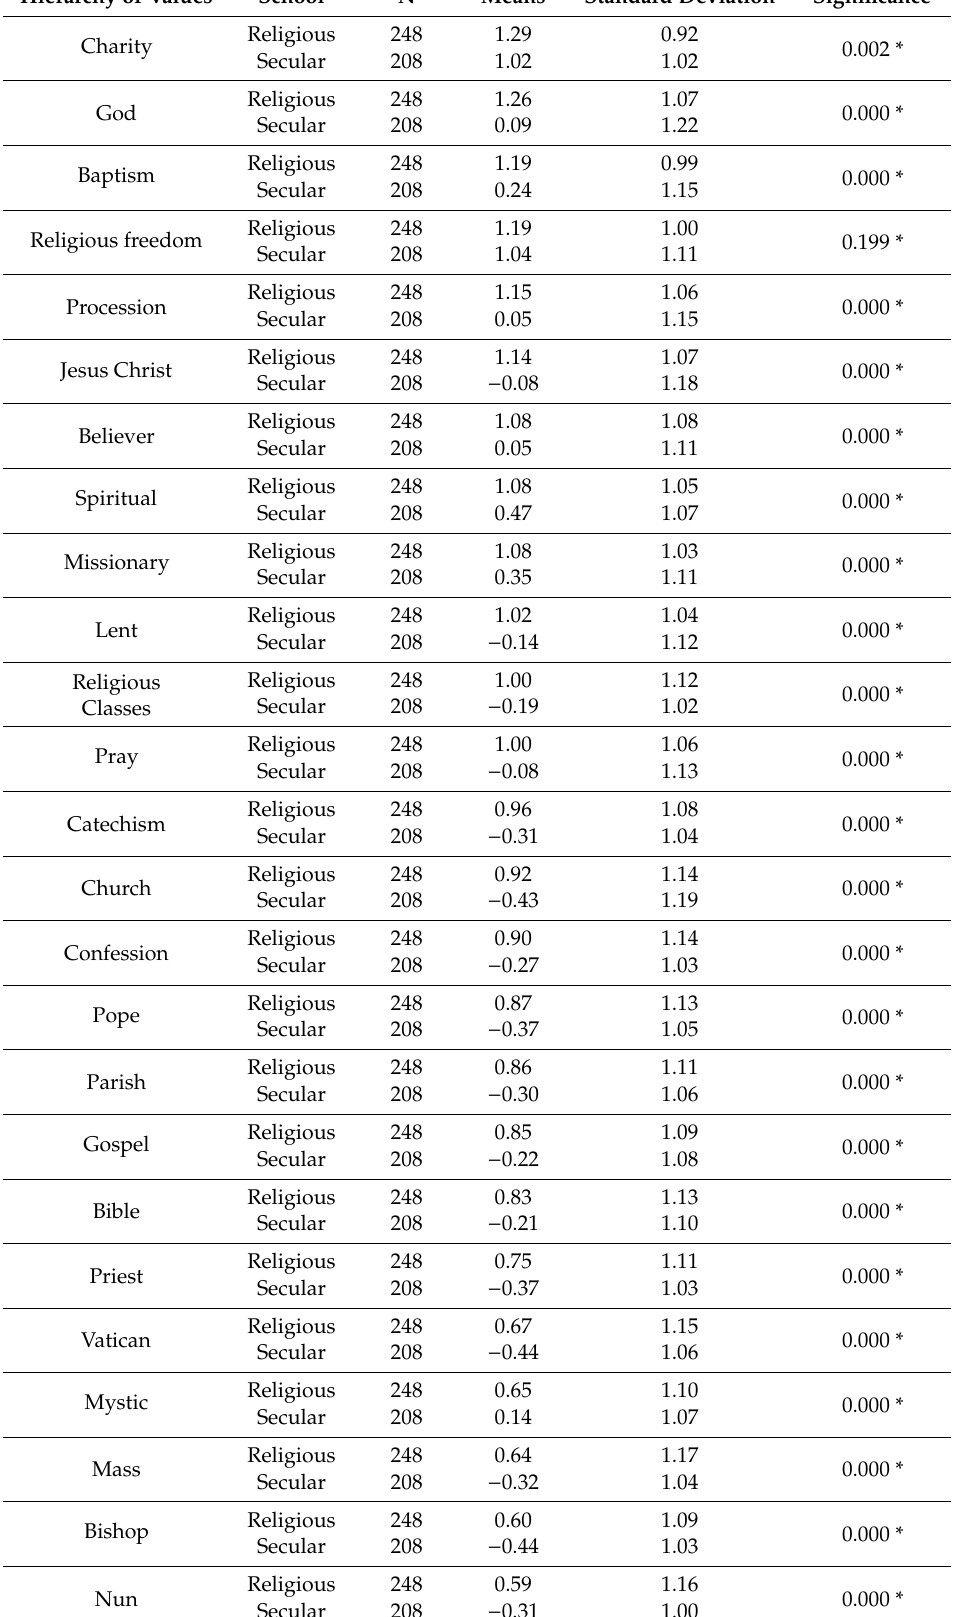
Table 7. One-way analysis of variance according to the school